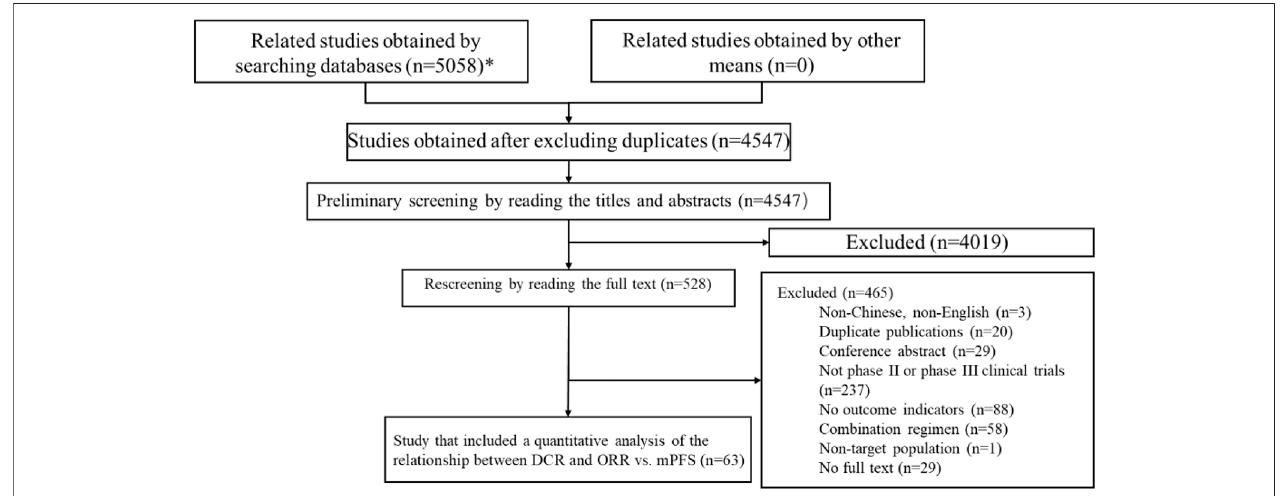
FIGURE 1 | Flowchart of literature